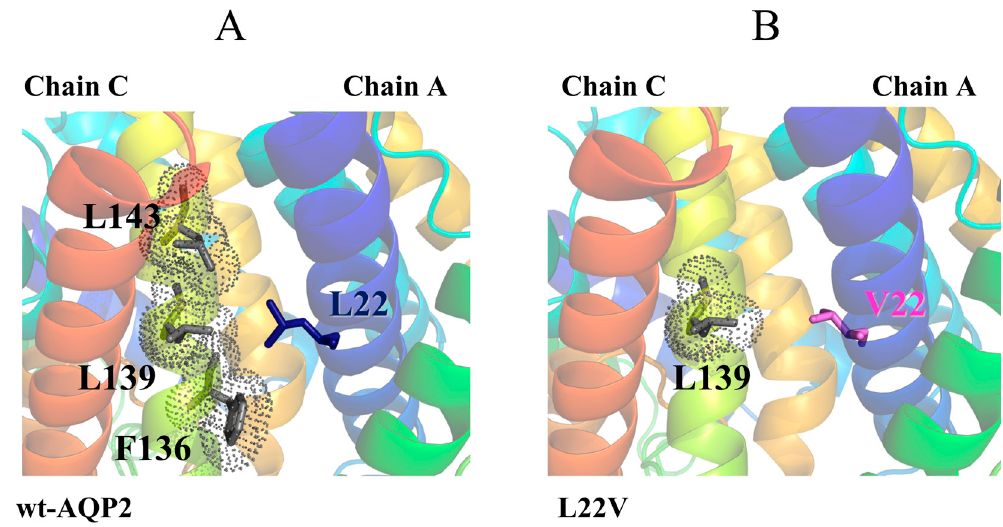
Figure 4. Tetramer assembly affecting L22V mutant. Cartoon representation of: ( A ) wt-AQP2 and ( B ) L22V mutant with discussed residues shown as sticks and labeled. The interacting residues are shown as gray Connolly surface.